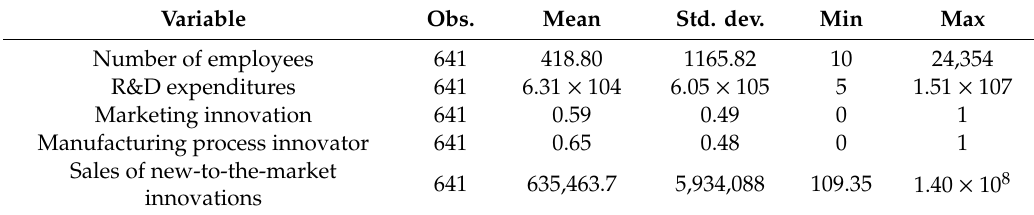
Table 2. The summary of statistics from the sub-sample of new-to-the-market innovators in 2014.